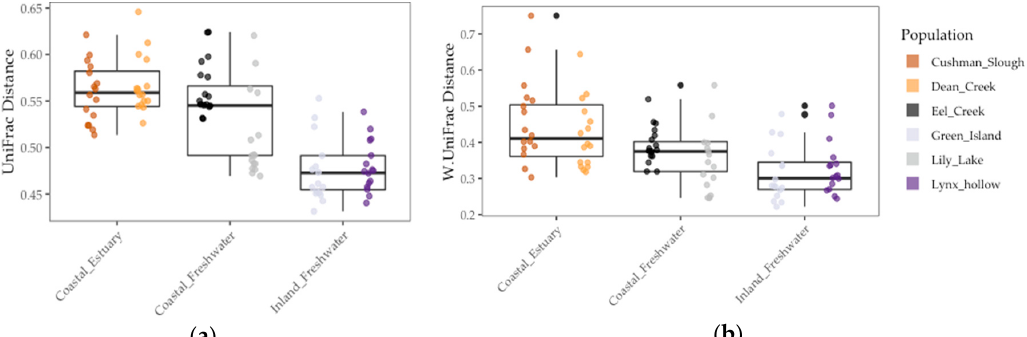
Figure 4. Gut microbiome beta diversity among threespine stickleback populations in terms of distance-to-centroid transformed: ( a ) Unweighted UniFrac distance ( b ) Weighted UniFrac distance. Colors represent collection sites (“populations”). Each point is a fish gut. Mid-box lines are pooled means of major environments (e.g., Coastal Freshwater”). Box whiskers are pooled standard deviation of major environments, as